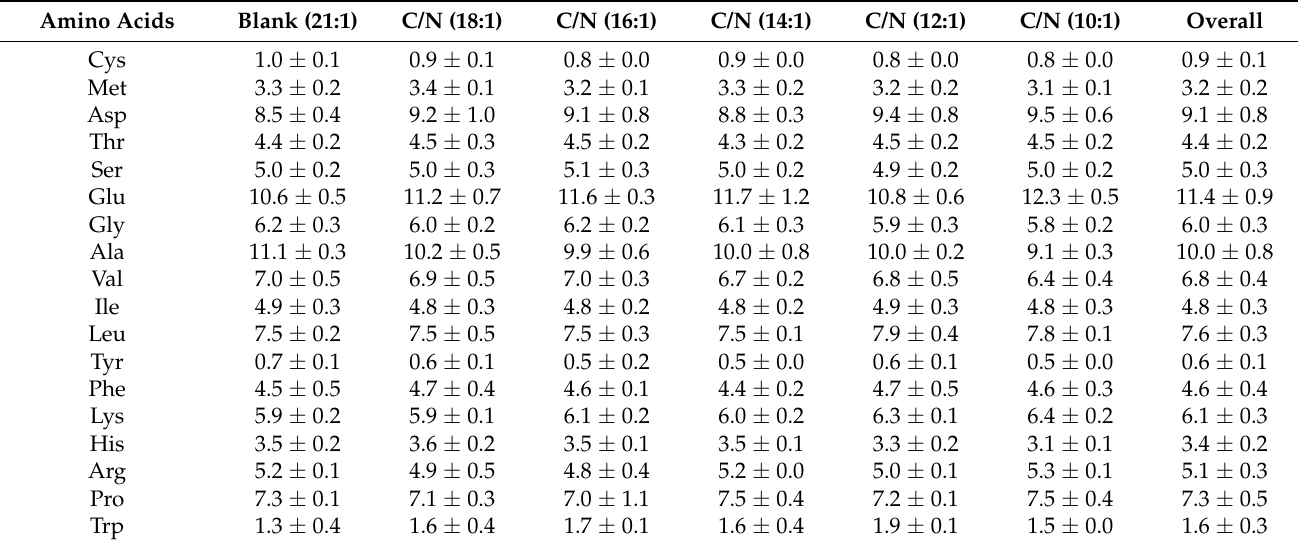
Table 3. Proximate amino acid compositions of larvae collected on Day 12 in Trial